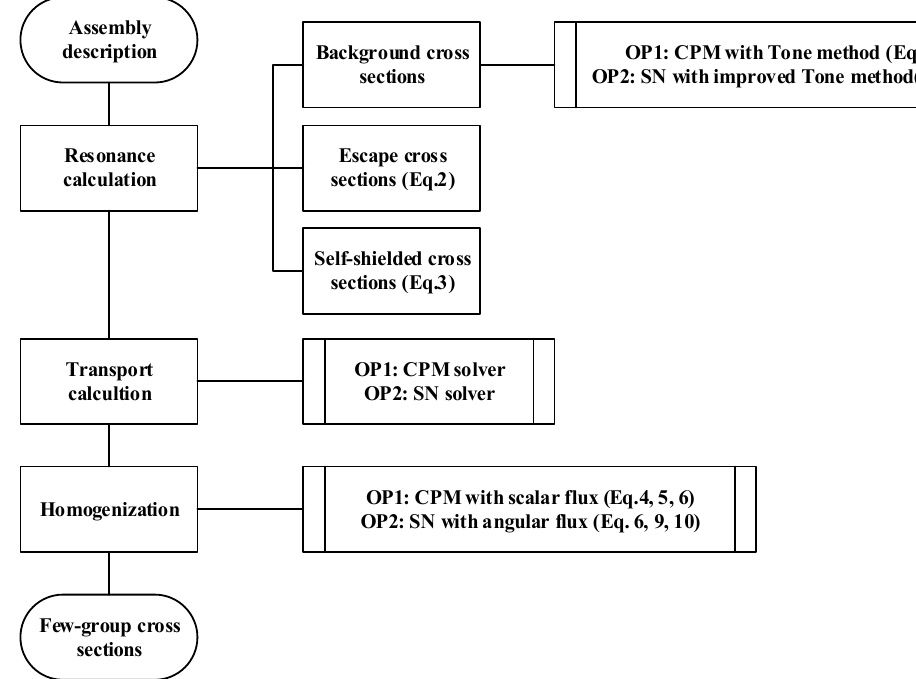
Figure 1. The computational flow chart of TULIP code.